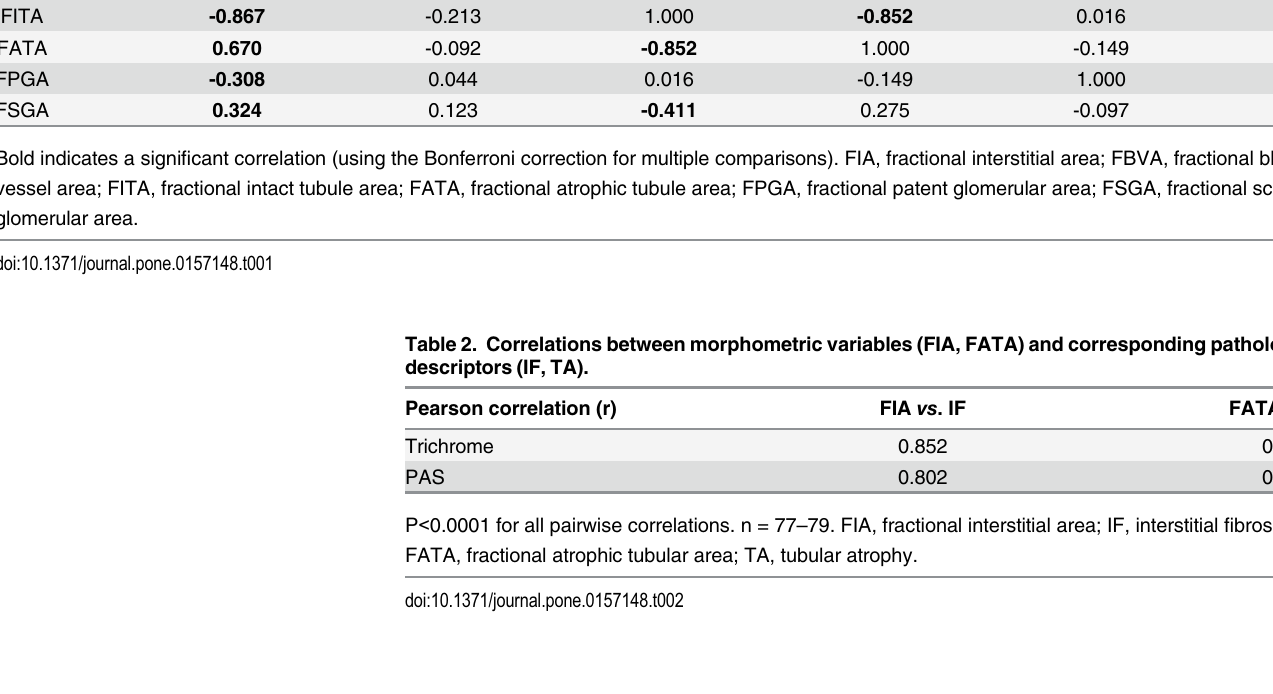
Table 1. Pearson correlations among fractional cortical areas. FIA FBVA FITA FATA FPGA FSGA FIA 1.000 0.026 -0.867 0.670 -0.308 0.324 FBVA 0.026 1.000 -0.213 -0.092 0.044 0.123 -0.867 -0.213 -0.411 FATA 0.670 -0.092 -0.852 -0.149 0.275 FPGA -0.308 0.044 0.016 -0.149 1.000 -0.097 FSGA 0.324 0.123 -0.411 0.275 -0.097 1.000 Bold indicates a signi fi cant correlation (using the Bonferroni correction for multiple comparisons). FIA, fractional interstitial area; FBVA, fractional blood vessel area; FITA, fractional intact tubule area; FATA, fractional atrophic tubule area; FPGA, fractional patent glomerular area; FSGA, fractional sclerotic glomerular area.